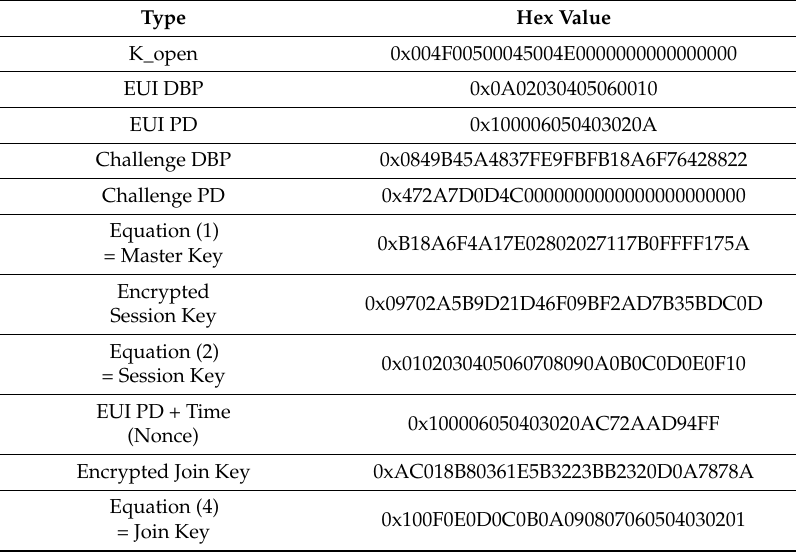
Figure 3. Captured packet of OTA provisioning process using K_open. Table 1. Value of exploited keys and